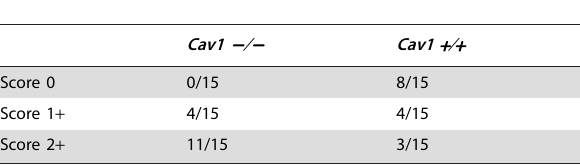
B6129 WT and Cav1-KO mice (n=15 per genotype) were infected with H. pylori SS1 for 11 months. Histopathological scores of gastritis were evaluated in H&E stainings of sections from paraffin-embedded stomach tissue. Score 0=no, 1 + =mild, 2 + =moderate, 3 + =severe gastritis. Fisher Exact p=0.001 (score 0